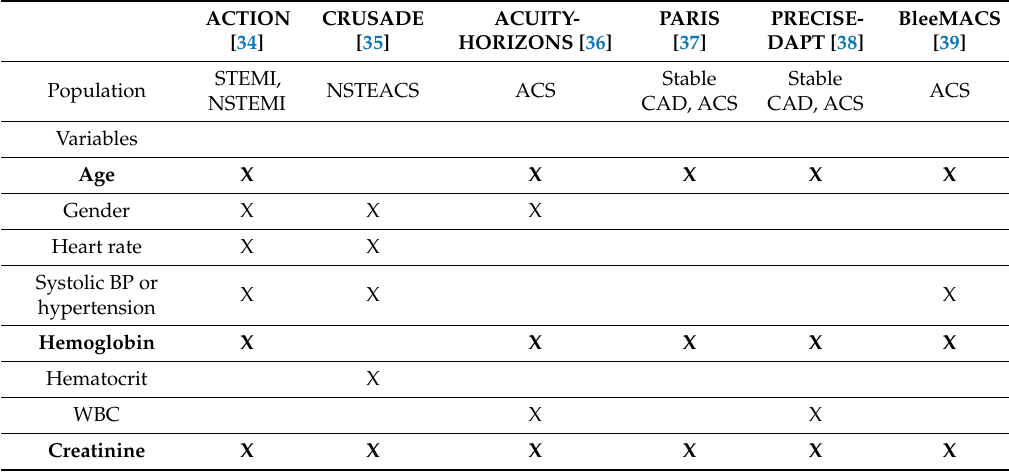
Table 2. Risk scores used to estimate bleeding risk in patients with coronary artery disease on antiplatelet therapy. * In the ACTION score, a lower body weight was associated to higher bleeding risk, with maximum risk when body weight was ≤ 50 kg. In the PARIS score, a body mass index < 25 or ≥ 35 was associated to higher bleeding risk. ACS, acute coronary syndrome; ATT, antithrombotic treatment; BP, blood pressure; CAD, coronary artery disease; ECG, electrocardiogram; HF, heart failure; NSTEACS, non-ST-elevation acute coronary syndrome; NSTEMI, non-ST-elevation myocardial infarction, OAT, oral anticoagulation therapy; STEMI, ST-elevation myocardial infarction; WBC, white blood